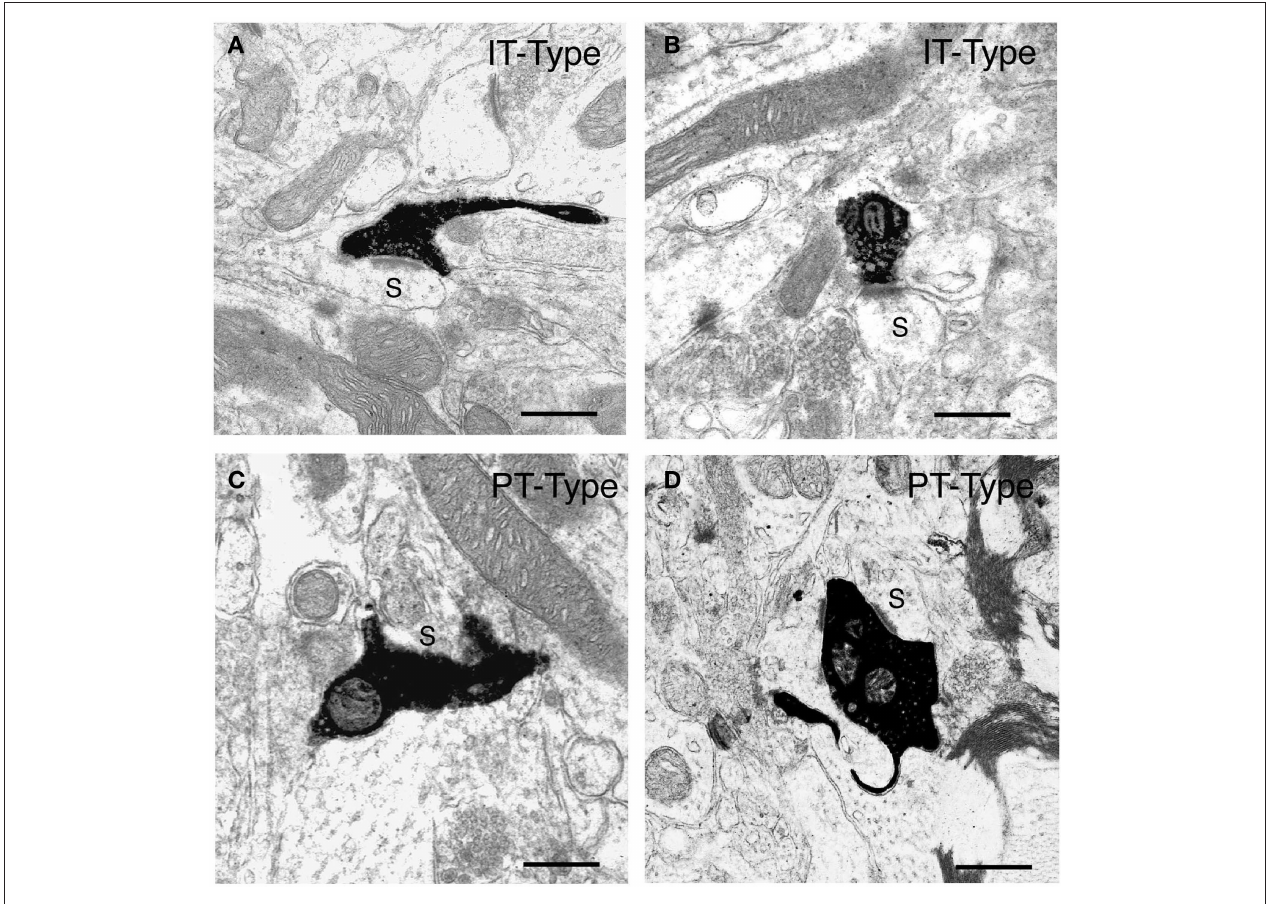
presumably belonging to striatal projection neurons. Note that the IT-type terminals are round, largely regular in shape, and about 0.5 μm in diameter, while the PT-type terminals shown are typically large, irregular in shape, and in some cases envelop their postsynaptic target structure. Scale bars = 0.5 μm in ( A–D